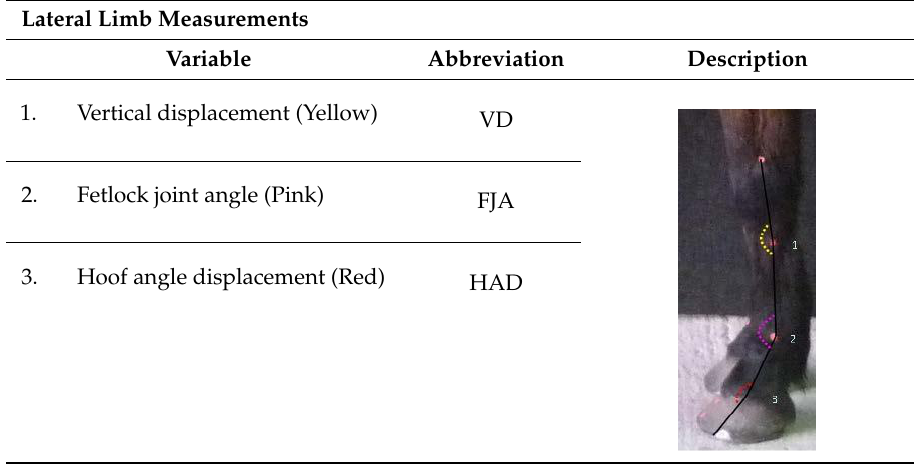
Table 4. Angular and linear morphometric variables measured from the 2D lateral view of the limb.